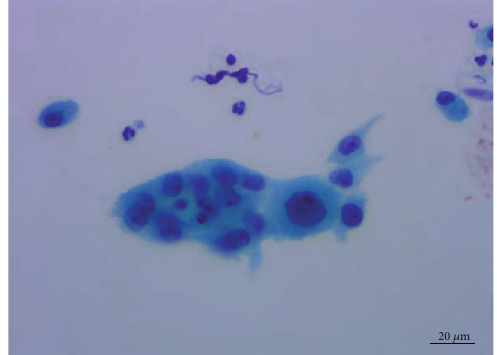
Figure 7: Moderate nuclear atypia cells which were 3 times the size of the contrastive cells. Pap staining, ×